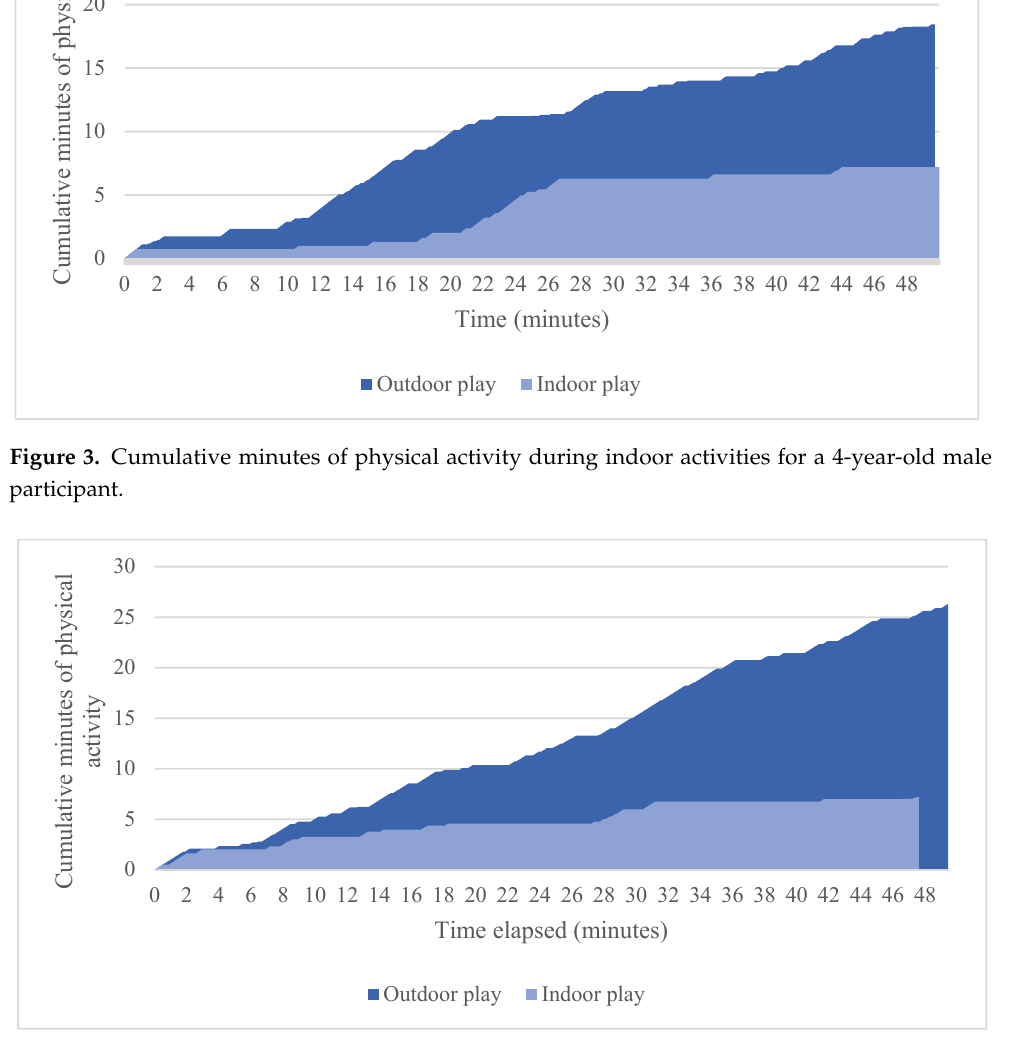
Figure 4. Cumulative minutes of physical activity during outdoor play versus indoor activities for a 5-year-old female participant .